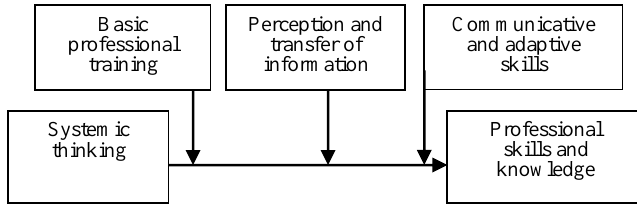
Fig. 1. Moderating and basic competences model (mid-term future